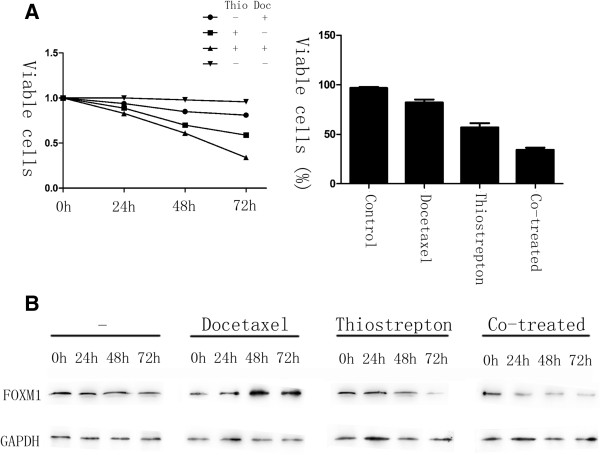
Thiostrepton can reverse docetaxel resistance in gastric cancer cells. AGS-DOCR cells were treated with DMSO (vehicle control), 0.02 mg/L docetaxel, 16 mg/L thiostrepton or a combination of 0.02 mg/L docetaxel and 16 mg/L thiostrepton for 72 h. (A) The percentage of viable cells in different treatment group is shown at each time point by MTT assay. (B) Cell lysates were prepared at 0, 24, 48, and 72 h after treatment, and the expression of FOXM1 and GAPDH were analyzed by western blot analysis.